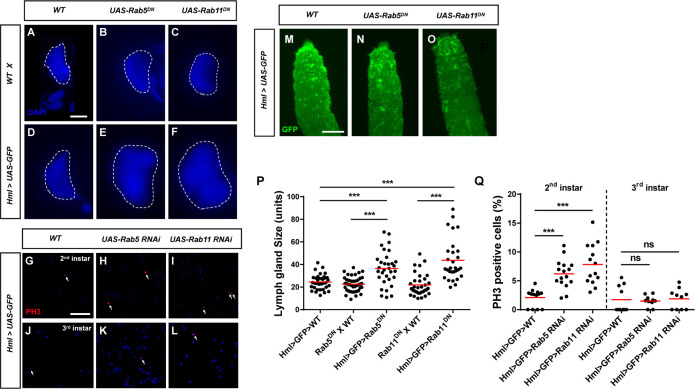
Analyses of lymph gland size and cell proliferation in circulating hemocytes as well as the sessile hemocyte pattern.(A–F, P) Lymph glands were labeled with DAPI to measure the anterior lobe area. The anterior lobe areas in different genotypes are shown in (P). (G–L, Q) Cell proliferation was analyzed in hemocytes from second instar (G–I) and third instar larvae (J–L) via anti-PH3 antibodies, and the PH3-positive cell percentage is shown in (Q). (M–O) The sessile hemocyte pattern was unchanged in Hml>UAS-Rab5/11DN larvae. Scale bars: 50 μm (lymph glands and hemocytes) and 500 μm (larvae). ns, not significant; ***p<0.001 (one-way ANOVA).